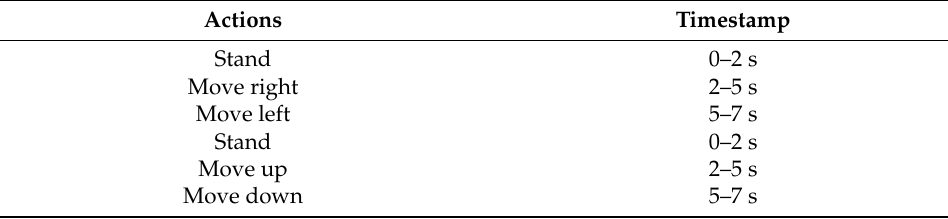
Table 1. Action design.